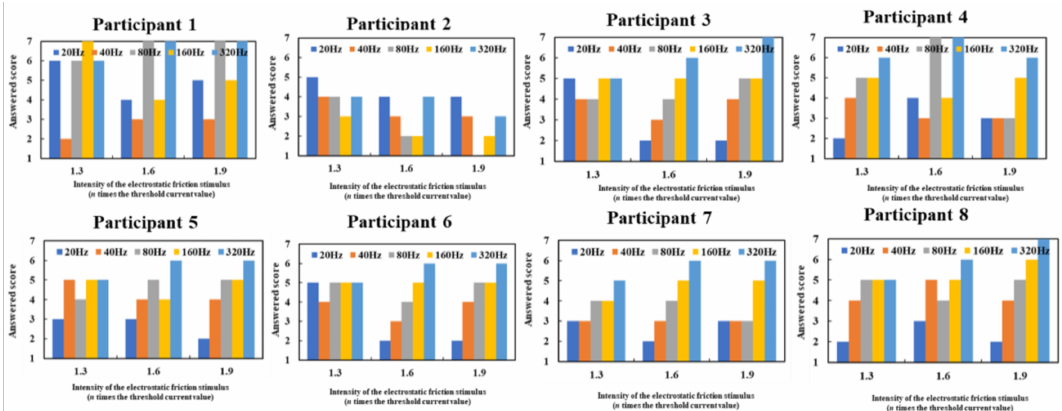
Figure A2. Score of electrostatic friction stimulus for each